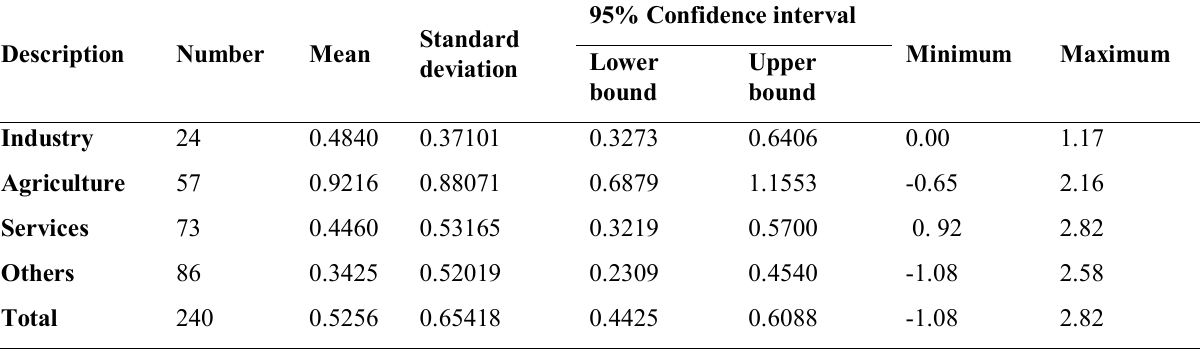
Table 12–Descriptive statistics of ROA (various sectors at middle quartile of investment)